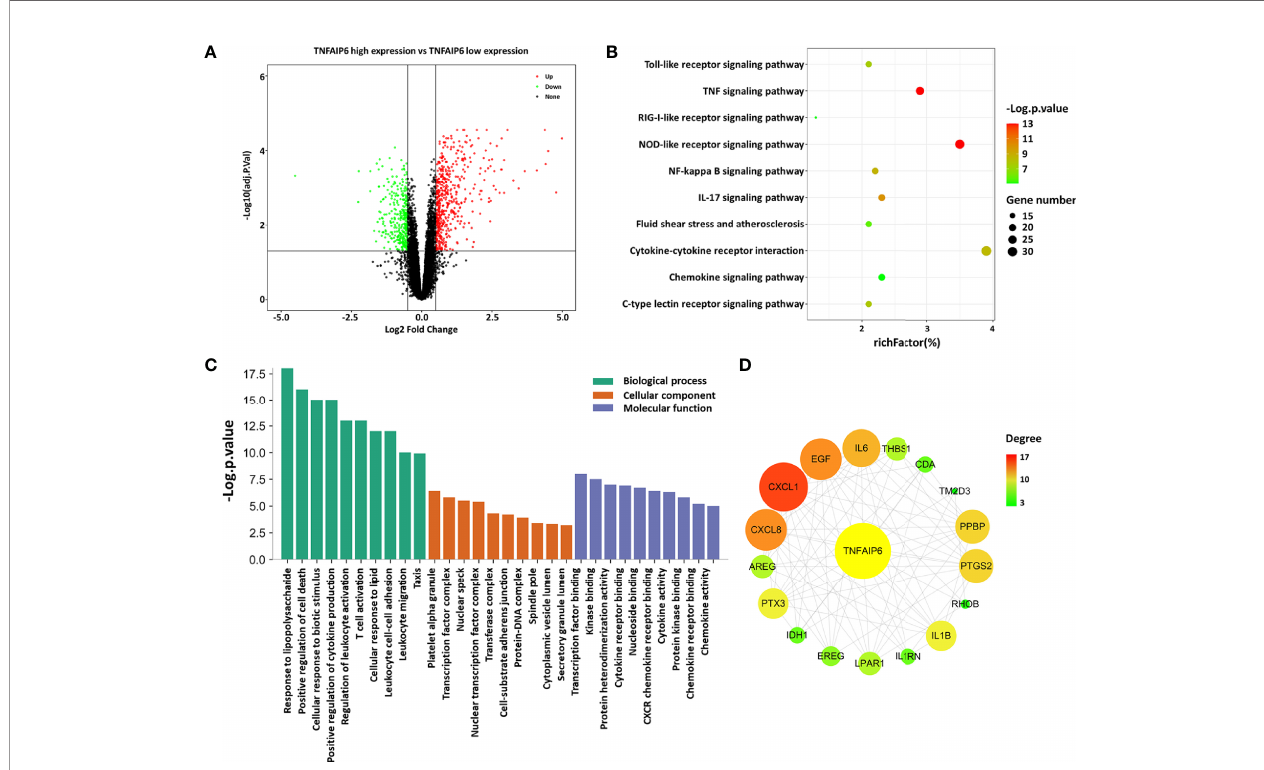
FIGURE 3 | Analysis of differently expressed genes. (A) Volcano plot of TNFAIP6 low/high: green represents downregulated genes, red represents upregulated genes, and black represents no signi fi cant differently expressed genes. (B) KEGG pathways analysis: the enriched signi fi cance gradually increases from green to red, and the dot sizes indicate the number of differential genes contained in the corresponding pathway. (C) Enriched GO terms. (D) Protein – protein interaction network: circles represent gene-encoded proteins, the related degree gradually increases from green to red, and the circle sizes indicate the target-related degree to TNFAIP. AIS, acute ischemic stroke; KEGG, Kyoto Encyclopedia of Genes and Genomes; GO, Gene Ontology; PPI, protein – protein interaction.